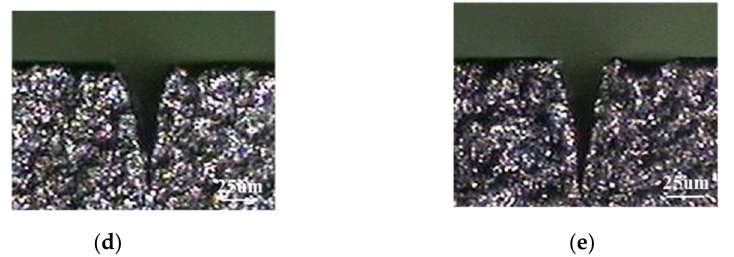
Figure 8. Optical microscope observation of the effect of variation in the number of cutting passes per path on the kerf depth in laser cutting of PCD workpiece (laser processing parameters were set at average power of 25.5 W, pulse width of 200 ns, and repetition rate of 170 kHz): ( a ) 1 pass per path; ( b ) 3 passes per path; ( c ) 5 passes per path; ( d ) 7 passes per path; ( e ) 9 passes per path.